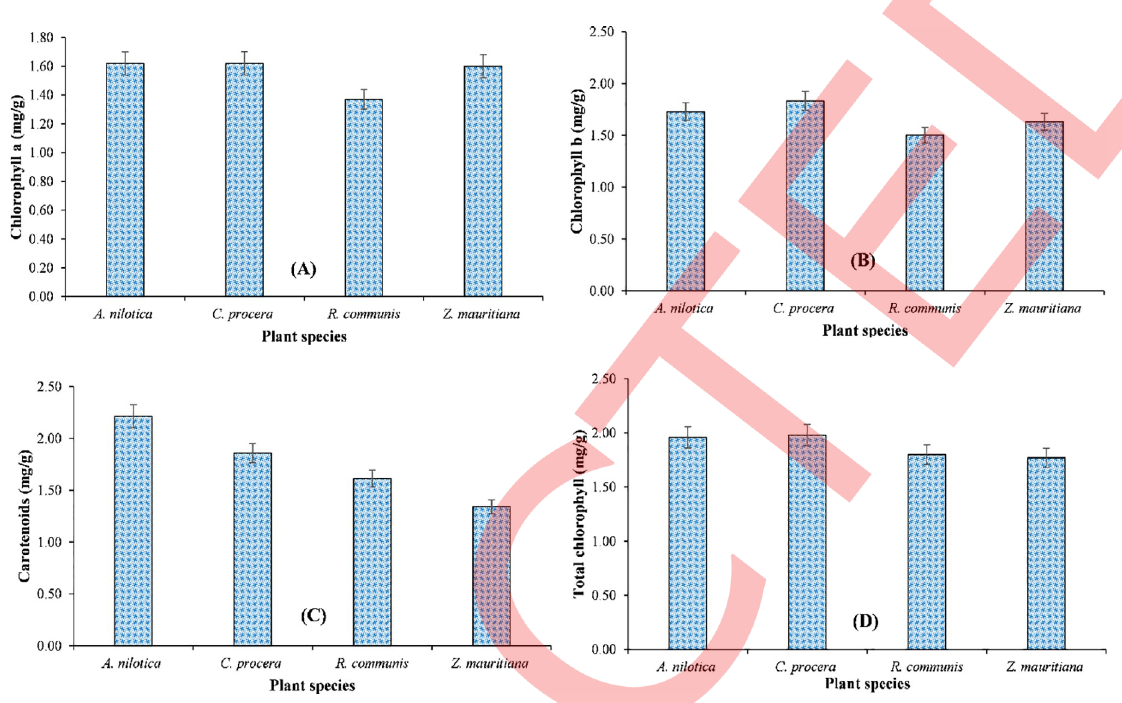
Fig 4. Physiological attributes of different wild plant species growing on roadside in a heavy automobile emission area. https://doi.org/10.1371/journal.pone.0249147.g004 in was lower at all sites in all plants except control site. Besides, chlorophyll b amount at all site was lower than control site (Table 3). Similarly, in all plant species concentration of chloro- phyll b was highest at the control site as compared to all other sites (Table 3). Table 3. Interactive effect of wild plants and sites on different biochemical parameters of studied plant species.